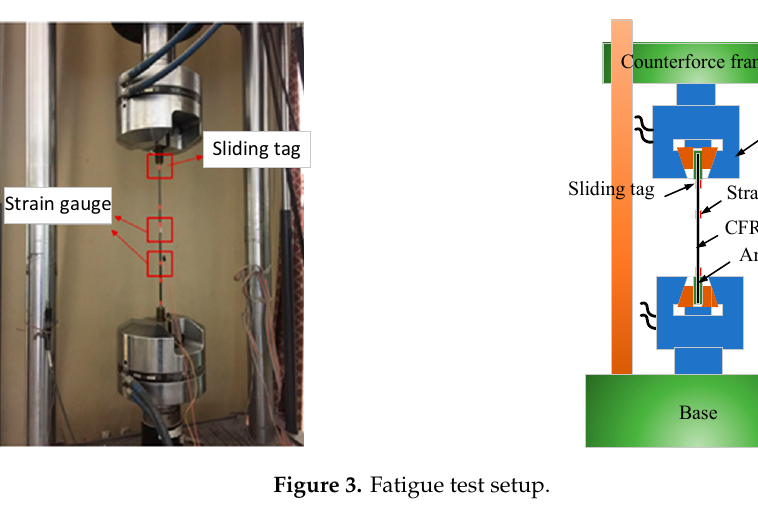
Figure 3. Fatigue test setup.